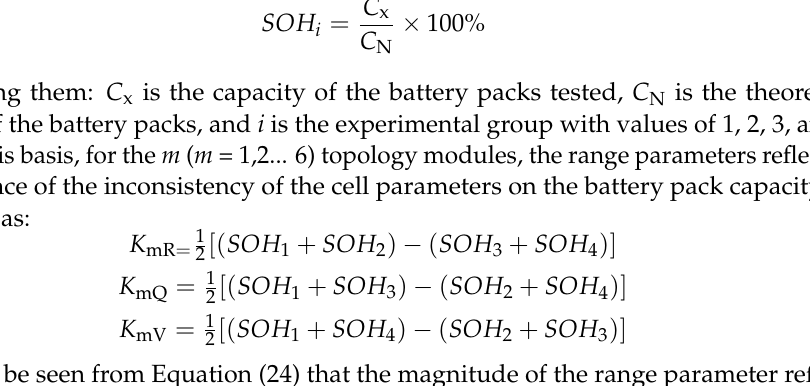
Table 5. Range of influence of parameter inconsistency on module discharge capability. Range